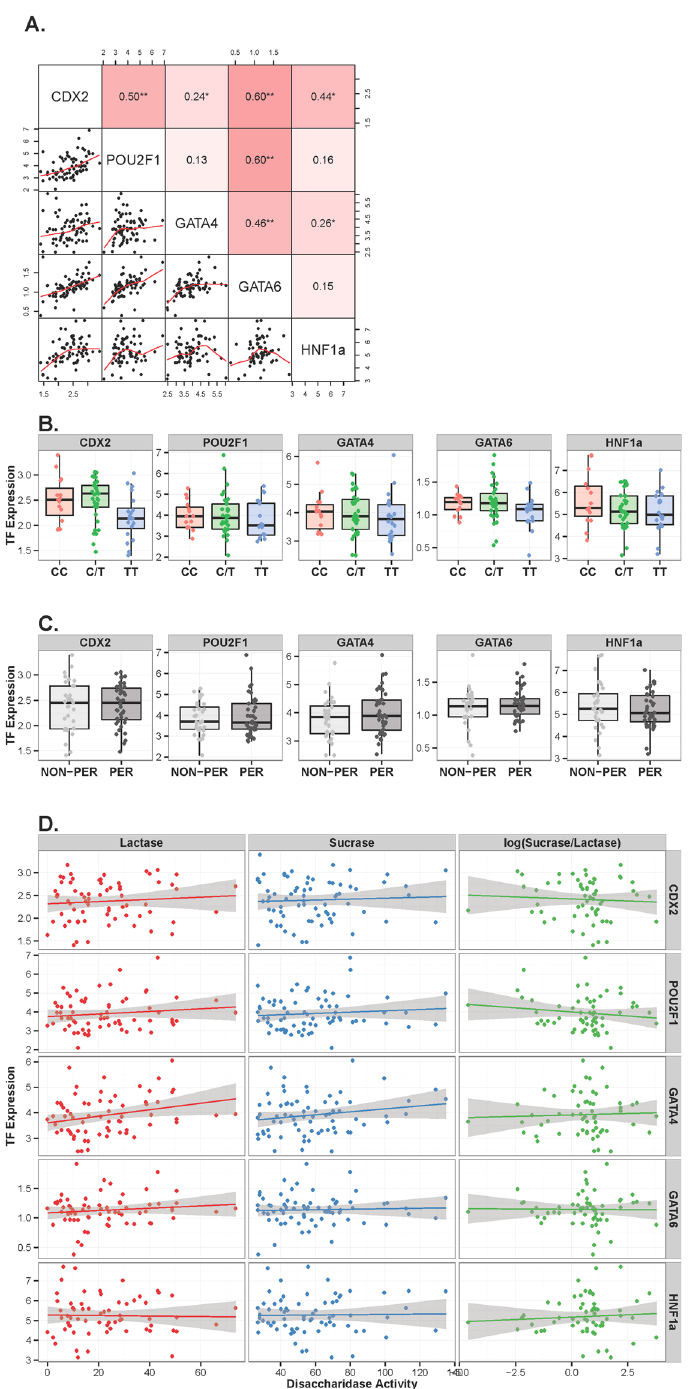
Figure 1. RT-qPCR analysis for major intestinal transcription factors (TF) in lactase persistent and non- persistent individuals. ( A ) Spearman correlation coefficients (upper triangle) and scatter plots (lower triangle) between relative expression levels of CDX2, GATA4/6, POU2F1 and HNF1 α . The intensity of color corresponds to the relative strength of the associations ( * p < 0.05; ** p < 0.001). ( B) Relative expression of transcription factors CDX2, GATA4/6, POU2F1 and HNF1 α in individuals belonging to CC, C/T or TT genotypes at rs4988235 normalized to beta-ACTIN and GAPDH. ( C) Relative expression of transcription factors CDX2, GATA4/6, POU2F1 and HNF1 α in lactase persistent and non-persistent individuals. ( D) Association between TF expression and disaccharidase enzymatic activity (enzymatic activity data from Baffour-Awuah et al . 8